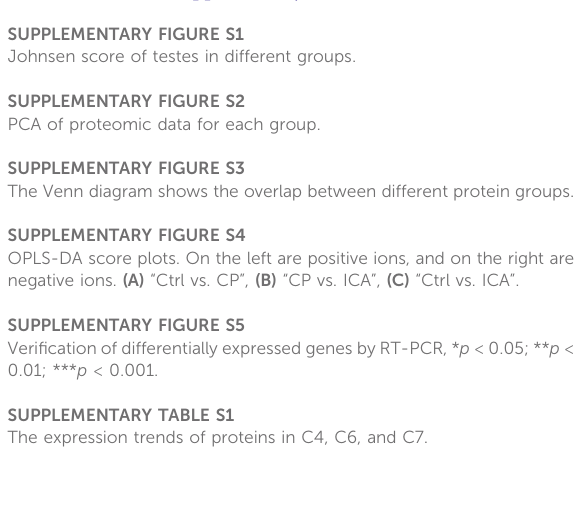
SUPPLEMENTARY TABLE S1 The expression trends of proteins in C4, C6, and C7.